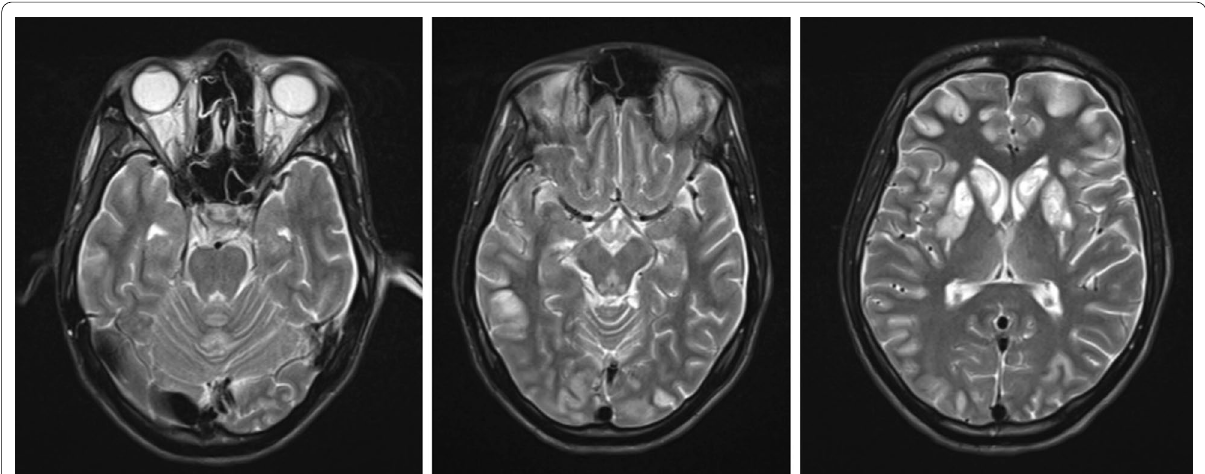
Fig. 1 MRI of the brain. Narrowing of the subarachnoid space. A pathological increase in the intensity of the signal by T2/TIRM and DWI from the cortex of the brain substance is determined, the change in the signal is symmetrical from the basal nuclei with their hemorrhagic transformation. Symmetrically increased T2/TIRM signal from the medial thalamus, periaqueductal gray